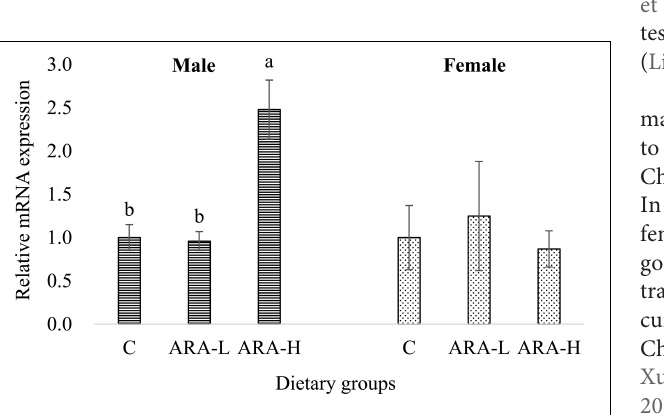
FIGURE 5 | Effects of experimental diets on mRNA expression of ch25h in the gonad of Chinese tongue sole. Results are expressed as means ± standard error. Different letters above the bars denote significant ( P < 0.05) differences among dietary groups.